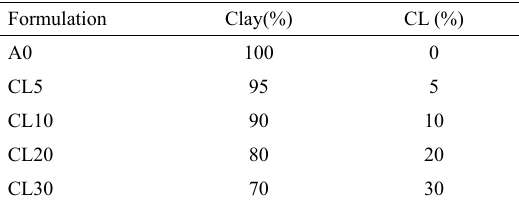
Table 1. Percentages of each